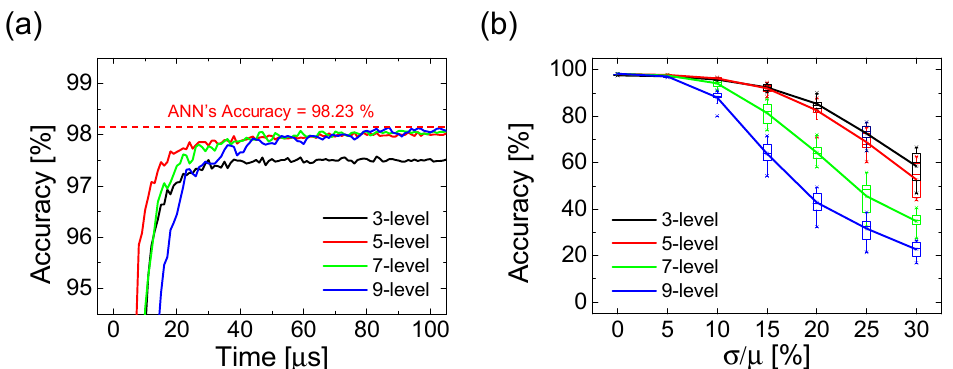
Figure 7. ( a ) Classification accuracy according to the simulation time when 3, 7, 5, and 9-level of the quantization weights transferred by the proposed method are used; ( b ) the variation effects on the classification accuracy with 3, 7, 5, and 9-level of the quantization weights. Table 1. Summary of the N and the accuracy according to the quantization